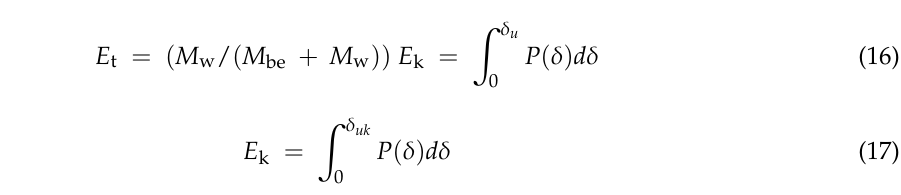
Figure 5. Conceptual diagram for estimating δ u and δ uk .